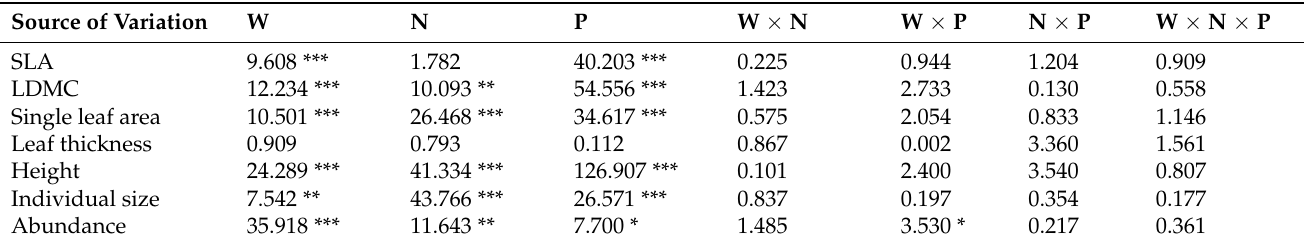
Table 2. Three-way ANOVAs for traits and abundance of Potentilla anserina in response to three main factors and their